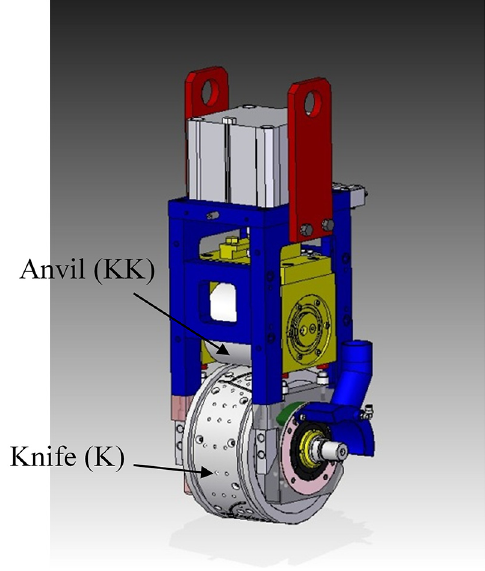
Fig. 1. 3D drawing of the fi rst test case [19,22].